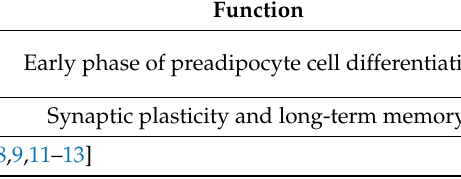
Early phase of preadipocyte cell differentiation.